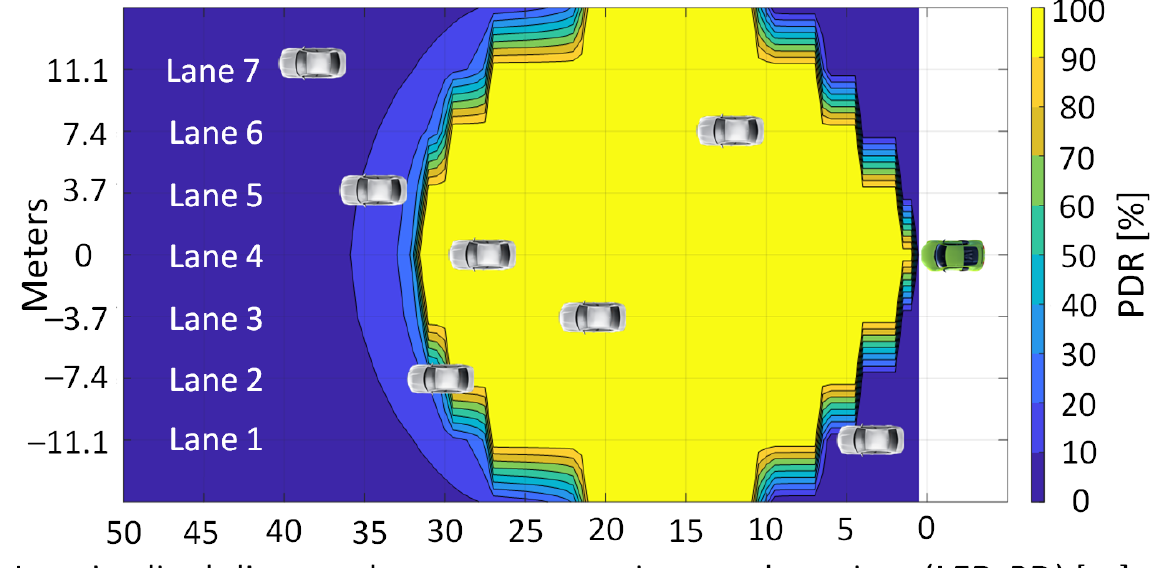
Figure 4. Geographical distribution of the packet delivery ratio for a V2V VLC link when transmitter (white vehicle) and receiver (green vehicle) are on a seven-lane road segment and no interference sources are within the area.